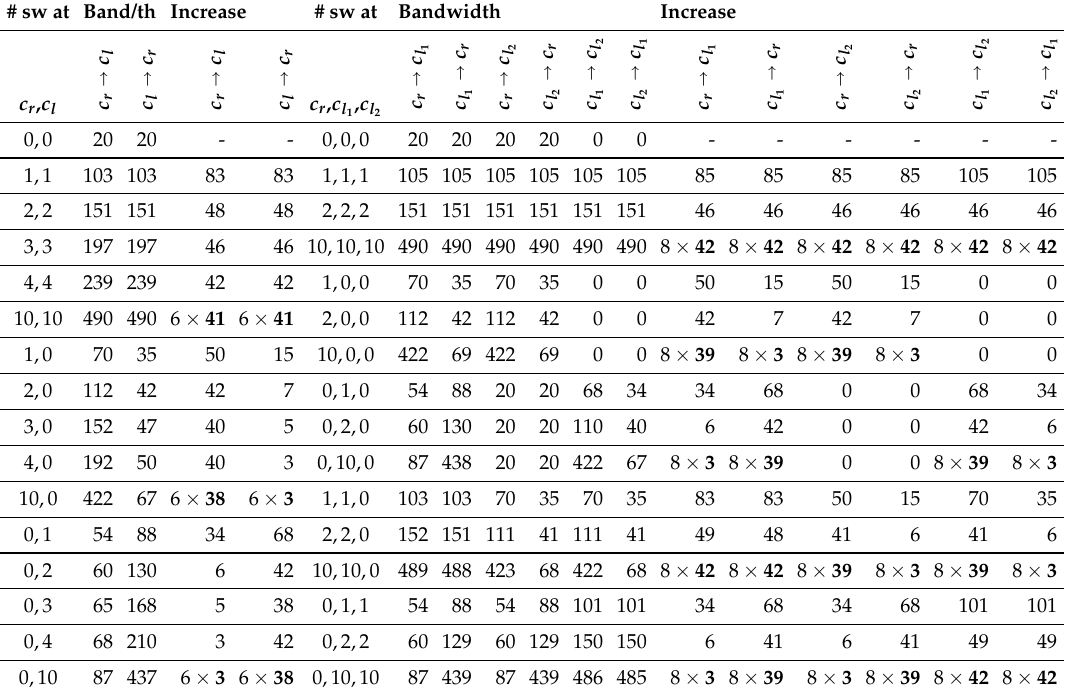
Table 2. The Ctr–Ctr bandwidth requirements in kbps for two or three Kandoo controllers. In the left part of the table, there are two controllers, the root ( c r ) and the local ( c l ). In the right part, there are three controllers, which are named as root ( c r ), local-1 ( c l ) and local-2 ( c l ). 2 1 # sw at Bandwidth